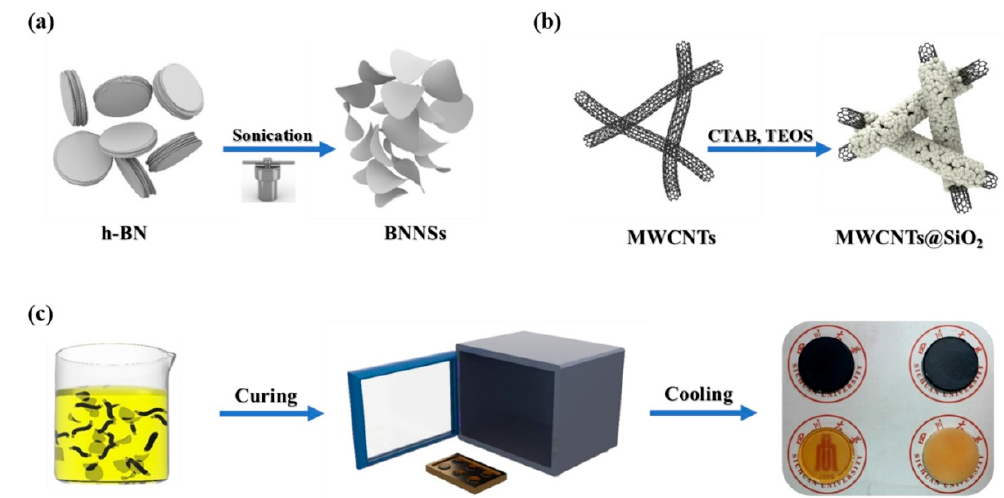
Figure 1. ( a ) The process of the liquid-phase exfoliation of h-BN. ( b ) Coating mesoporous silica on the surface of MWCNTs. ( c ) Preparation procedure of the BNNSs/MWCNTs@mSiO 2 /epoxy composites.